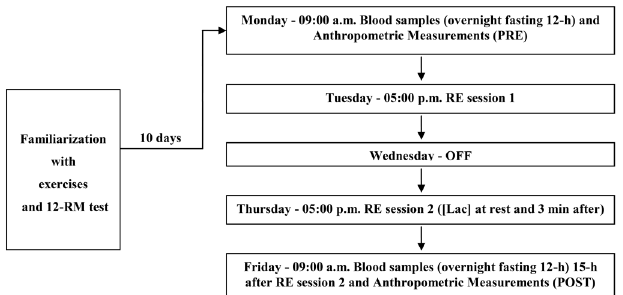
Figure 1. Experimental design. (12-RM = 12 repetition maximum; RE = resistance exercise; [Lac] = blood lactate